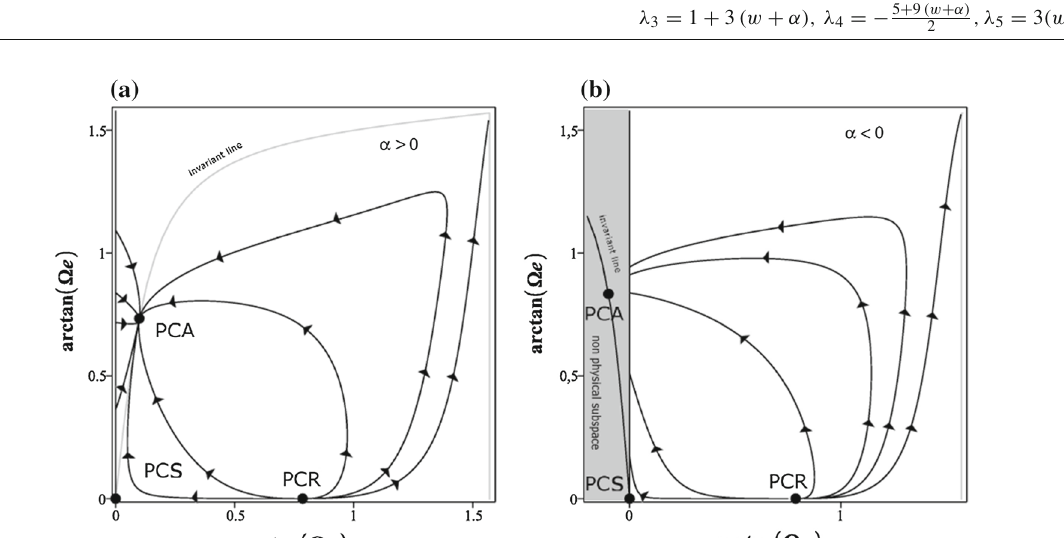
from the past attractor PC A , or it diverges. b Critical points and numer- ical trajectories of the dynamical system (20a–20e) in the homogeneous projection for α = − 0 . 1 and w = − 1 . 0. For some initial conditions choice the trajectory evolves to (cid:12) m q = 0 axis in the future, or it